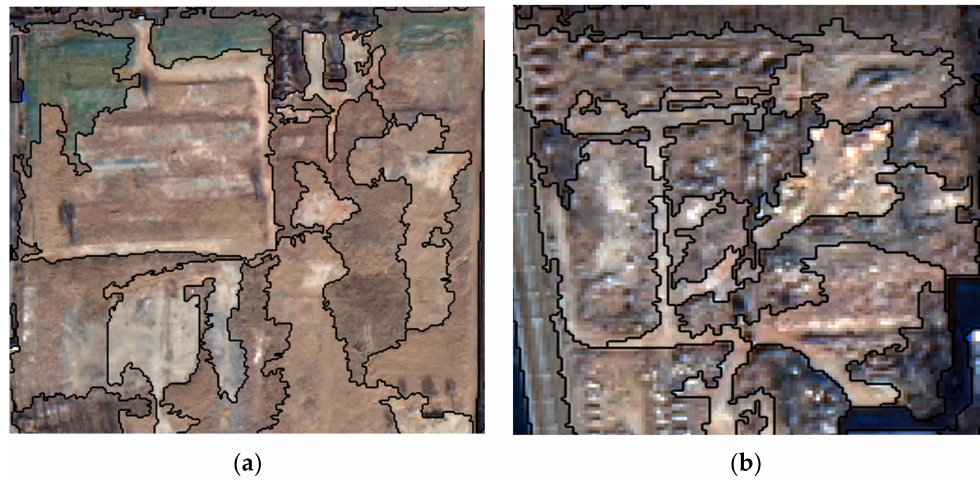
Figure 7. Significant differences in the texture features: ( a ) Bare soil, ( b ) construction